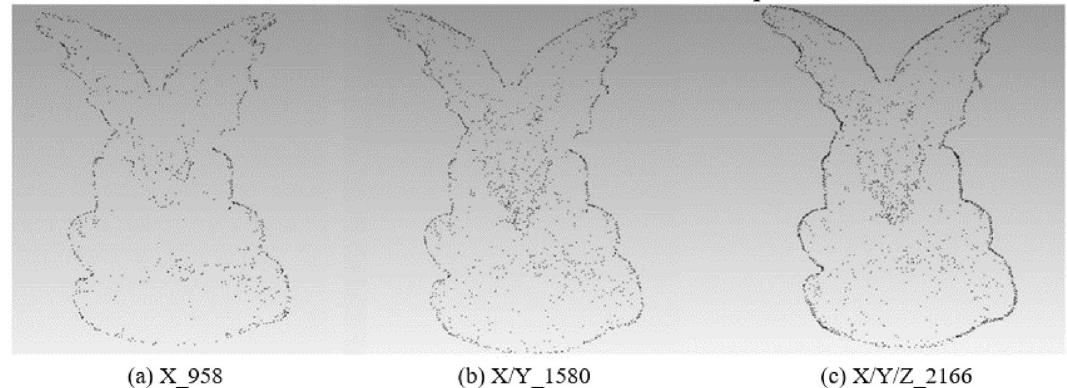
Figure 4. The point cloud with different numbers of feature points extracted with different axes for Gargo50k.